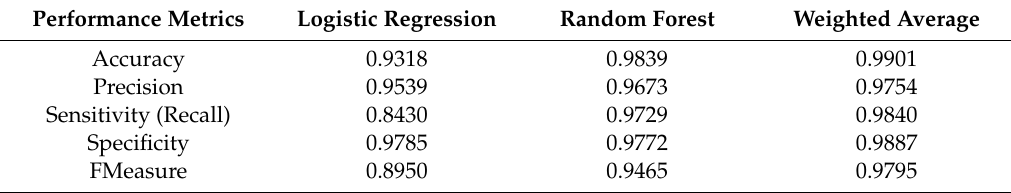
Table 2. Performance Evaluation of LR, RF, and the proposed Weighted Average Ensemble